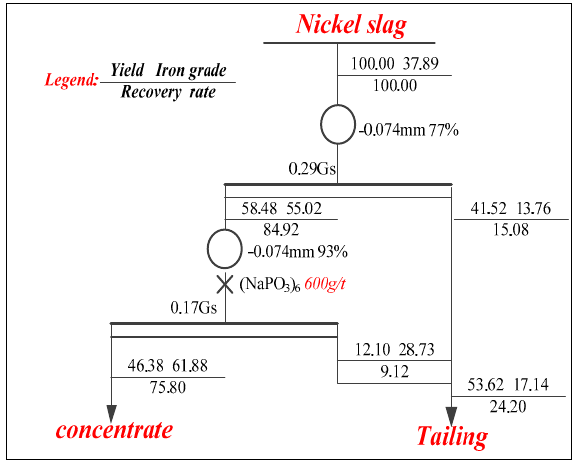
Figure 16. Flowsheet of two stage grinding low intensity magnetic separation process. Table 4. Chemical compositions of magnetic concentrate from the nickel slag (wt %).